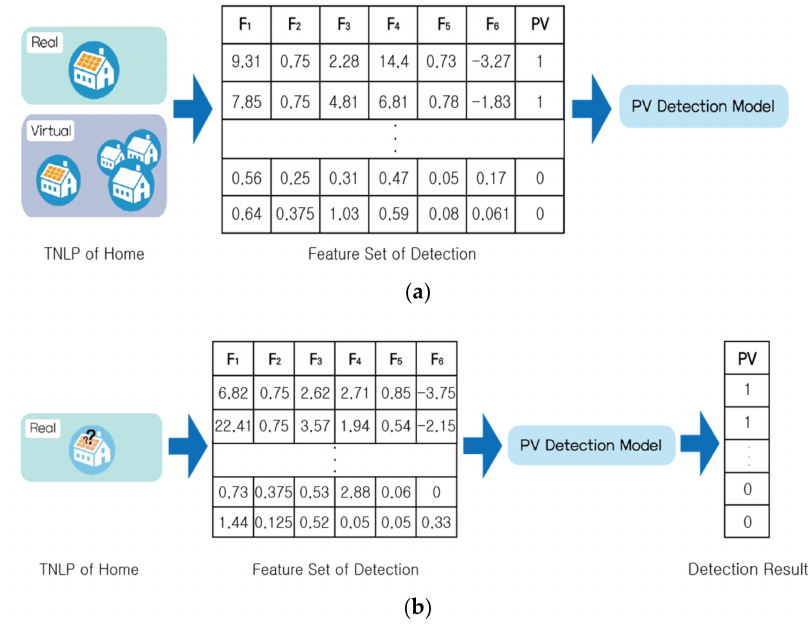
Figure 4. Process of unauthorized PV detection ( a ) training ( b ) test.